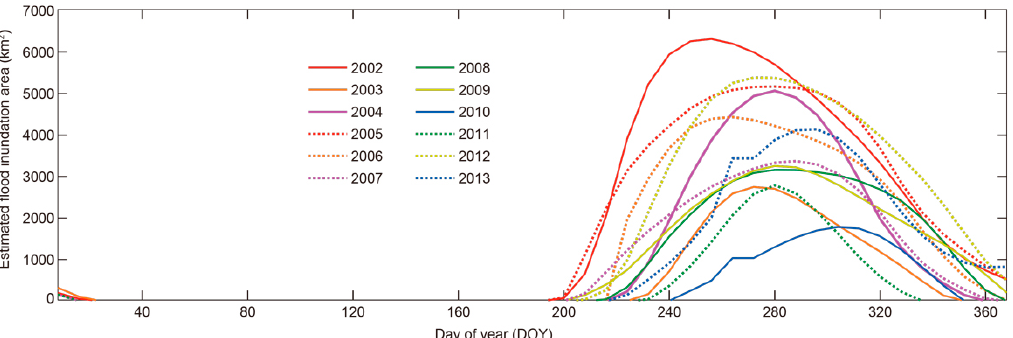
Figure 6. Seasonal changes in the extent of the estimated area of flood pixels with the method proposed.